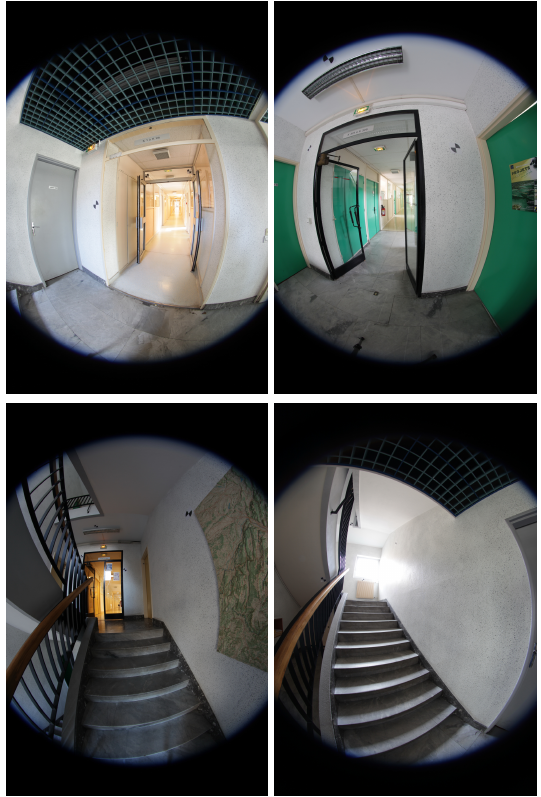
Figure 1: Stairway fish-eye